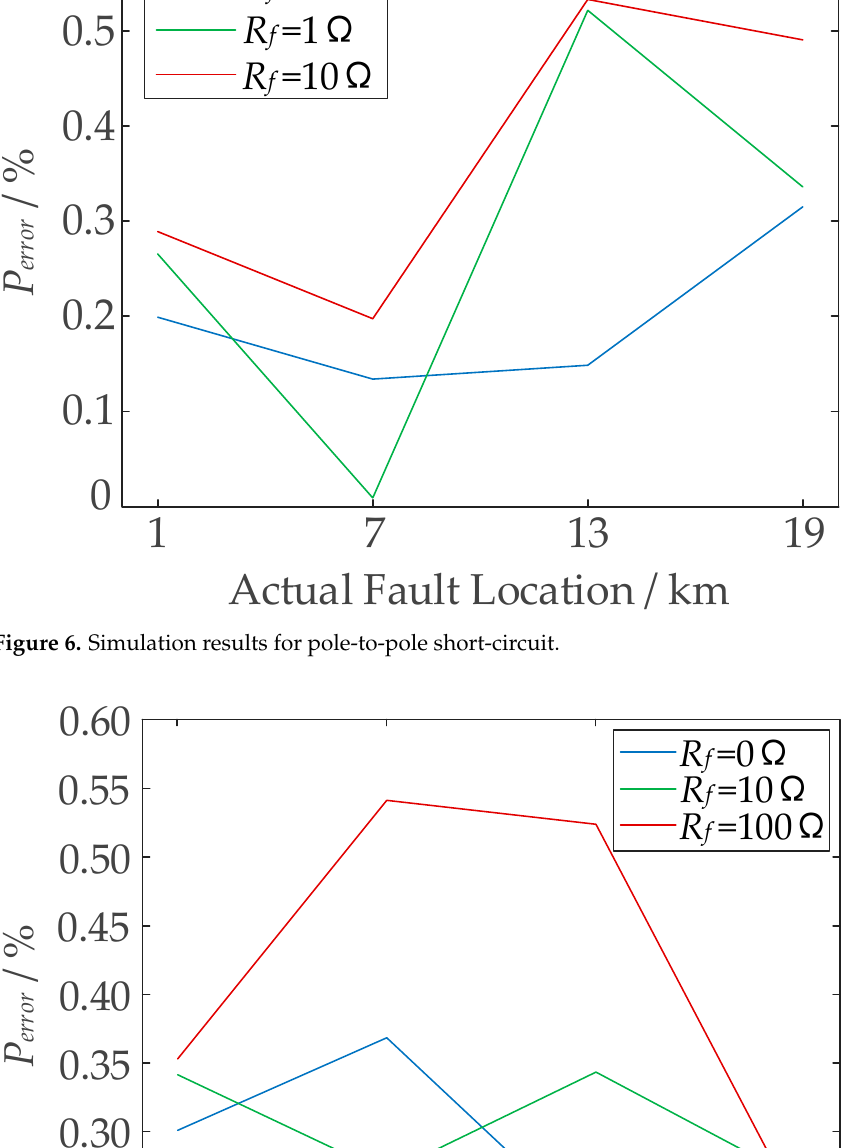
location for the whole DC line under different fault conditions, and is quite resistant to fault resistance.